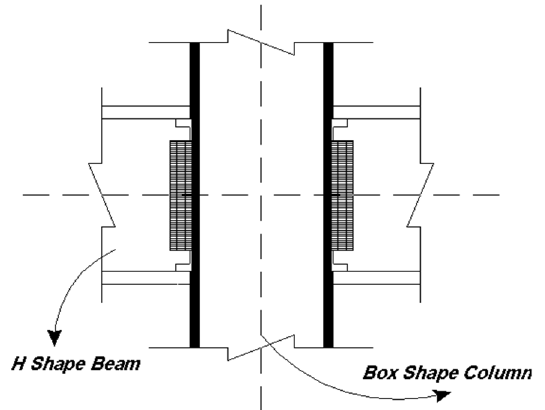
Figure 5. An overview of an example of a simple connection used (conventional connections before the Northridge earthquake).